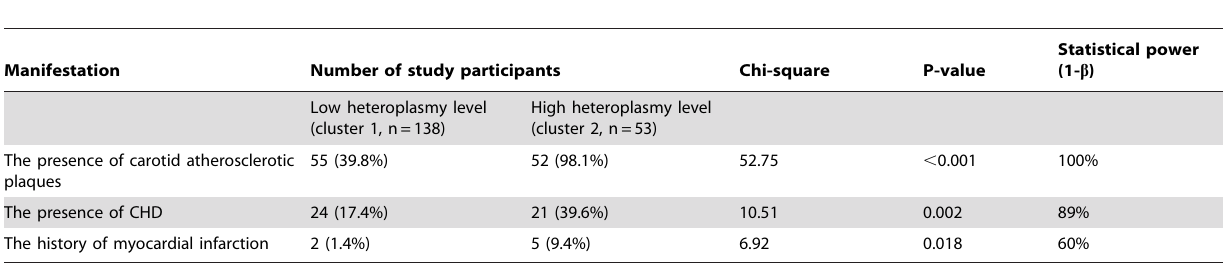
Table 3. Contingency of phenotypic and clinical manifestations of atherosclerosis with the level of C3256T heteroplasmy of mitochondrial genome.